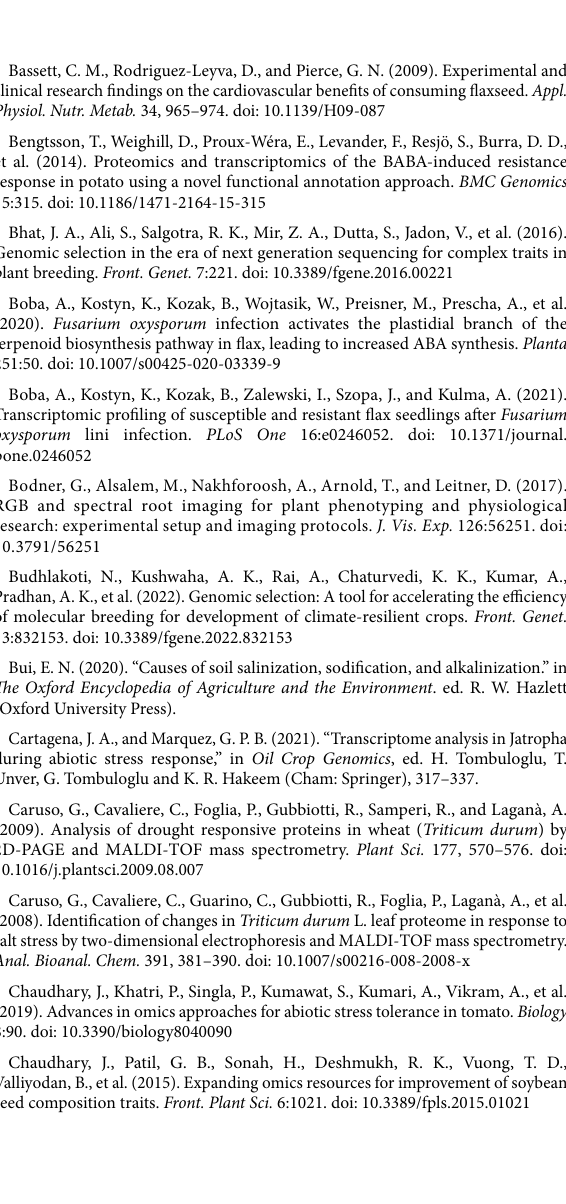
SUPPLEMENTARY FIGURE 1 Schematic diagram showing role of metabolomics in improving abiotic and biotic stress tolerance. SUPPLEMENTARY FIGURE 2 Information flow for ionomics and their role in stress